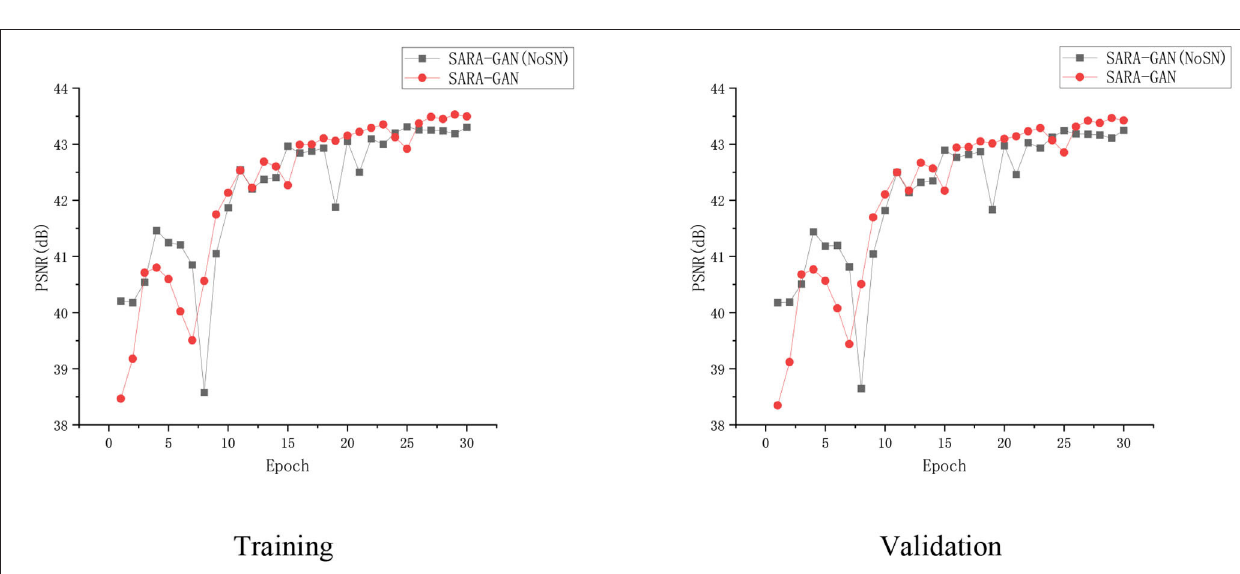
FIGURE 8 | The convergence curve of the PSNR vs. the Epoch number in the case of a 30% sampling rate with the 1D Gaussian mask. Training and